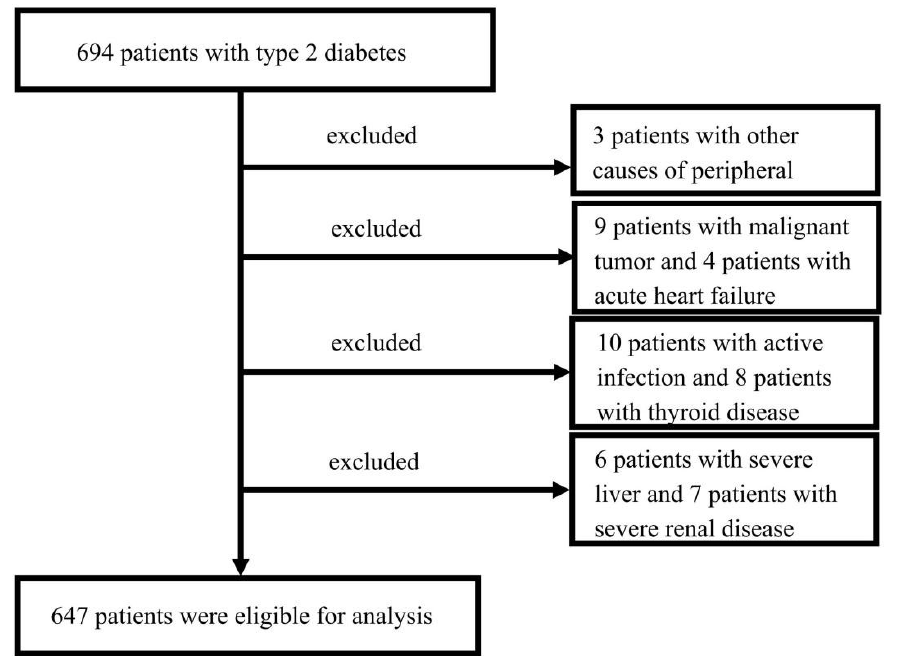
Figure 1. Flow chart showing the patient selection process.